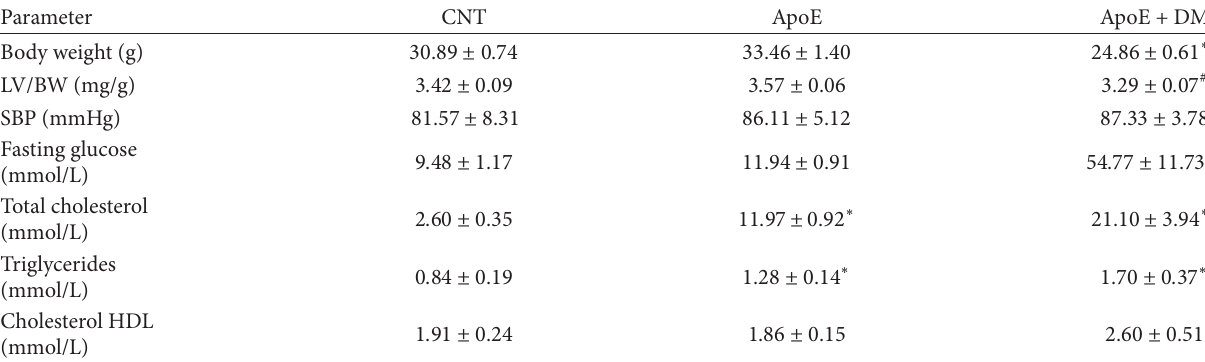
Table 1: General